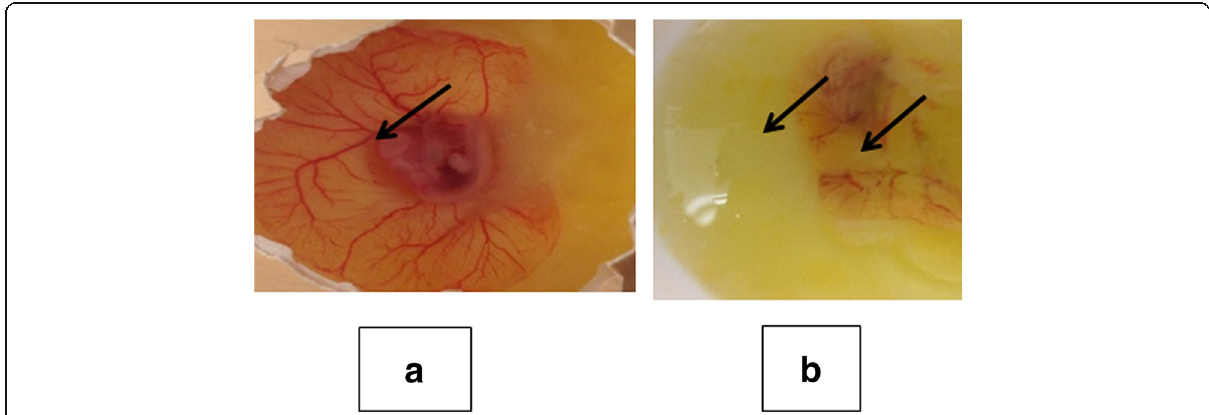
Fig. 9 a Ten days CAM showing angiogenesis with the arrow pointing at branched blood vessels. b CAM assay arrows showing the inhibition of angiogenesis in chick embryo due to localization of 5 μ g